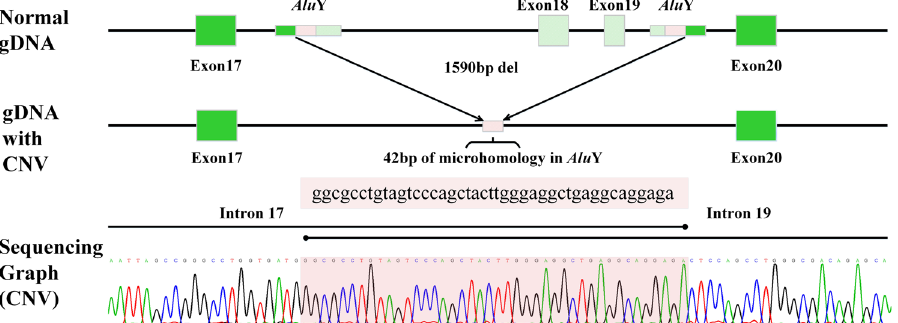
Figure 5. Length and breakpoints of the POMGNT1 CNV. The 1590-bp CNV of POMGNT1 included whole exons 18–19, as well as part of intron 17 and intron 19. The two breakpoints of the CNV localize to two Alu Y in intron 17 and intron 19. There are 42-bp of microhomology in two Alu Y resulting in Alu-Alu